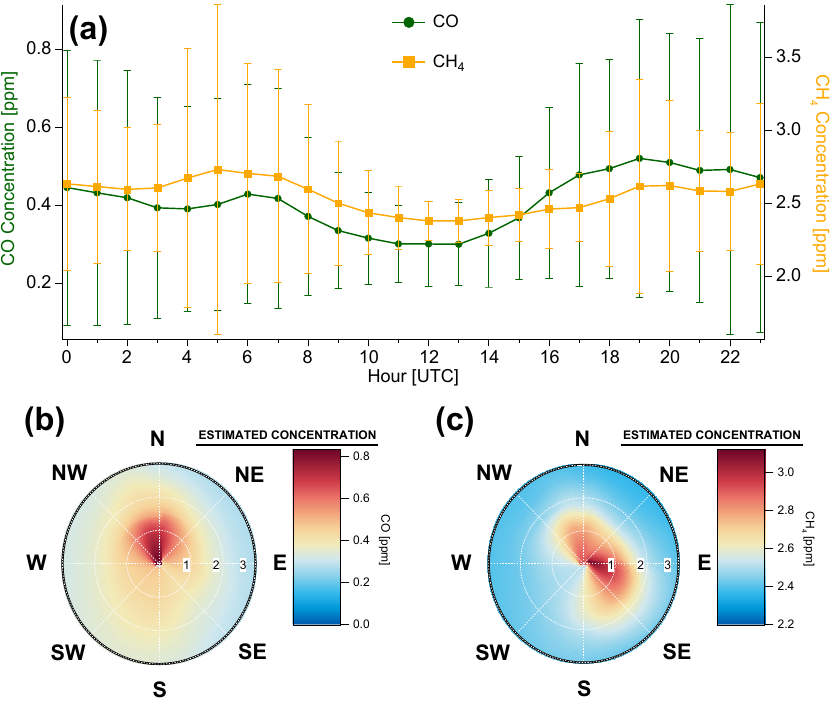
Figure 3. ( a ) Diurnal pattern computed for cold season between 1 December 2017 and 4 March 2018 of carbon monoxide (green line) and methane (yellow line) emphasizing peaks during morning and evening hours. The vertical error bars represent the standard deviation from the mean value. Source estimations are shown for: ( b ) CO; and ( c ) CH 4 . For the source estimation plots, the inner white circles represent the wind speed in m s − 1